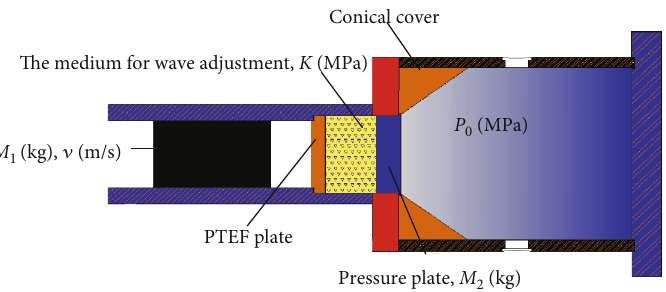
Figure 7: Formation mechanism of the stress wave in the developed experimental device.